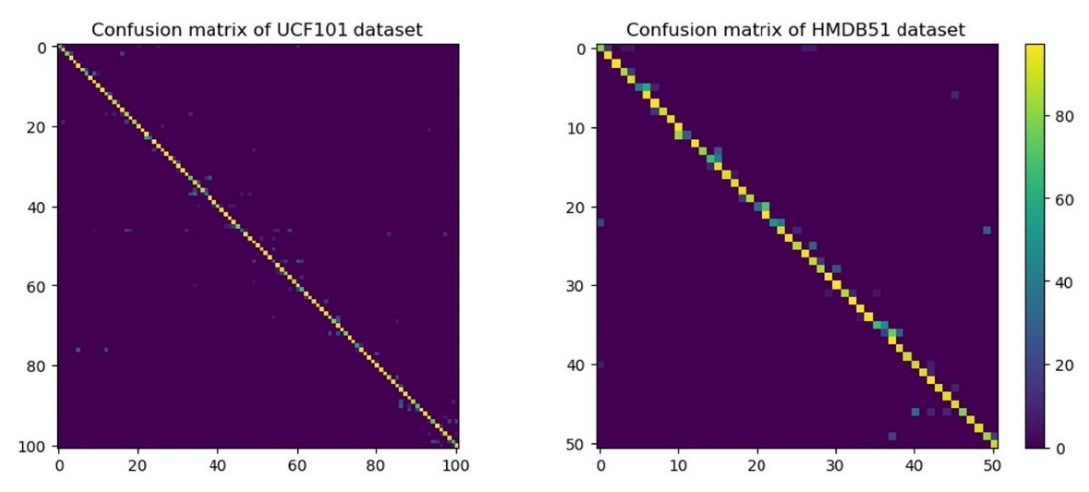
Figure 10. The confusion matrixes of UCF101 and HMDB51 dataset.